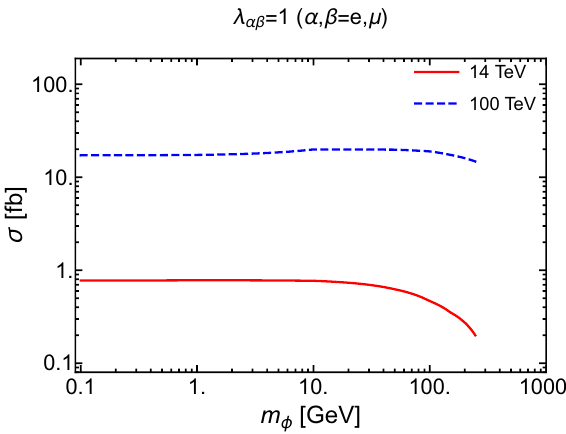
p ‘ (cid:6) (cid:30) jj process at s = 14 TeV and 100 TeV, as (cid:11) (cid:12)